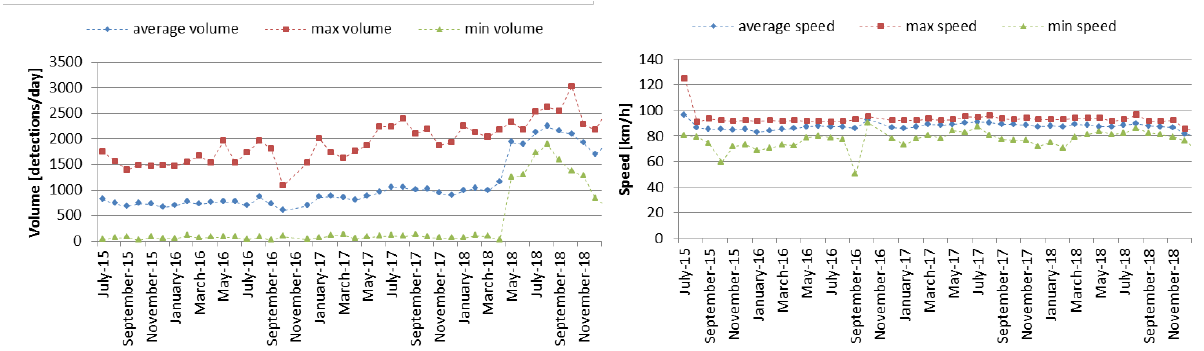
Figure 16: Number of detections and average speed for Route